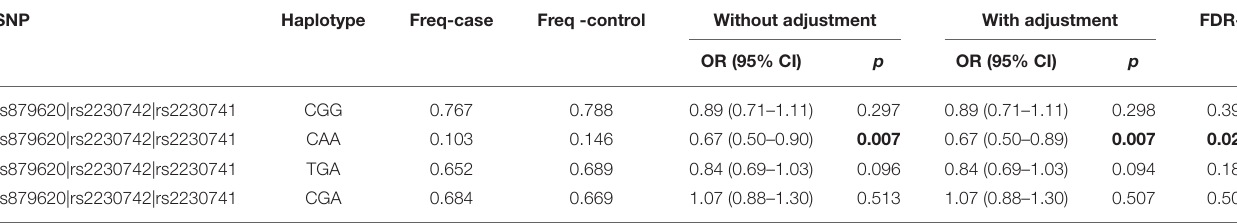
SNP, Single-nucleotide polymorphism; OR, Odds ratios; CI, Confidence intervals; FDR, False discovery rate. Significant values are marked in bold. With adjustment means adjusted by age and